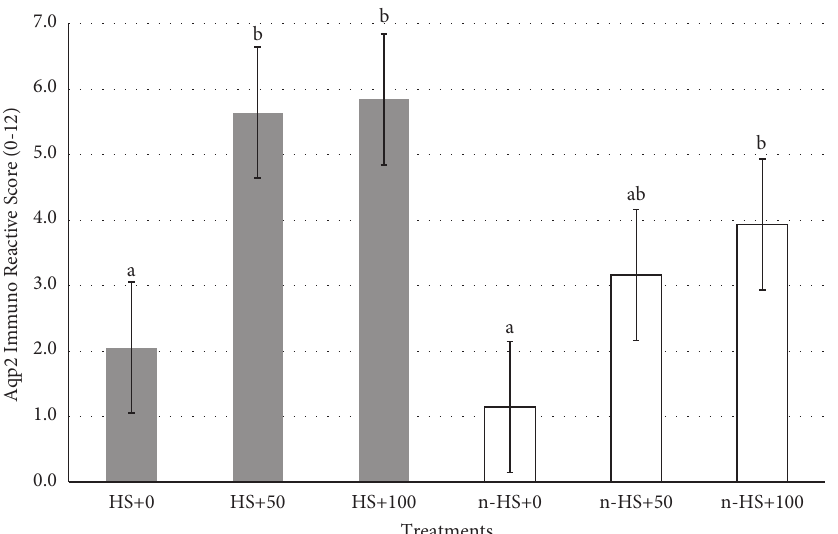
Figure 3: The average score of aquaporin 2 protein staining results in chicken kidney tubule tissue with Salix leaf extract under heat-exposed and unheated conditions. Different letters indicate significant ( P < 0 . 05) differences among treatments.